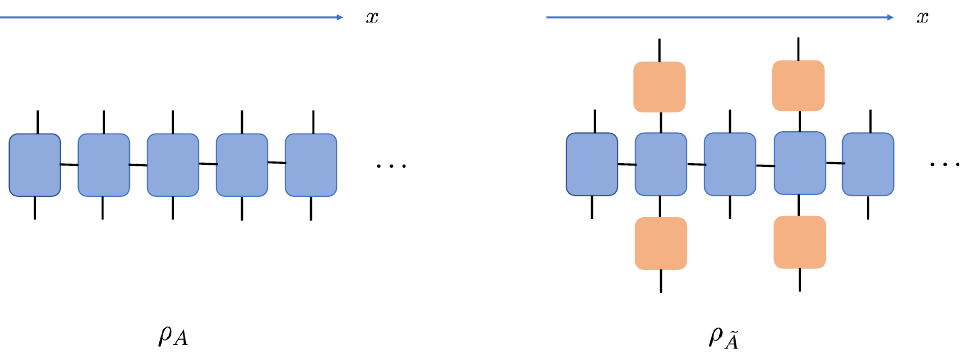
Figure 4 . (a) The density matrix of the half-space on a null sheet factorizes in interacting theories is entangled in the x direction (b) a shape deformation on the null sheet at point x = a corresponds to acting with unitaries U a